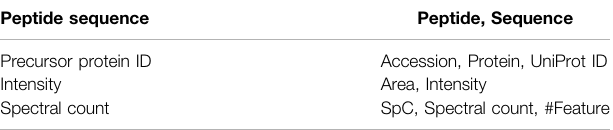
TABLE 1 | Allowed column names for the input fi les. Peptide sequence Peptide,